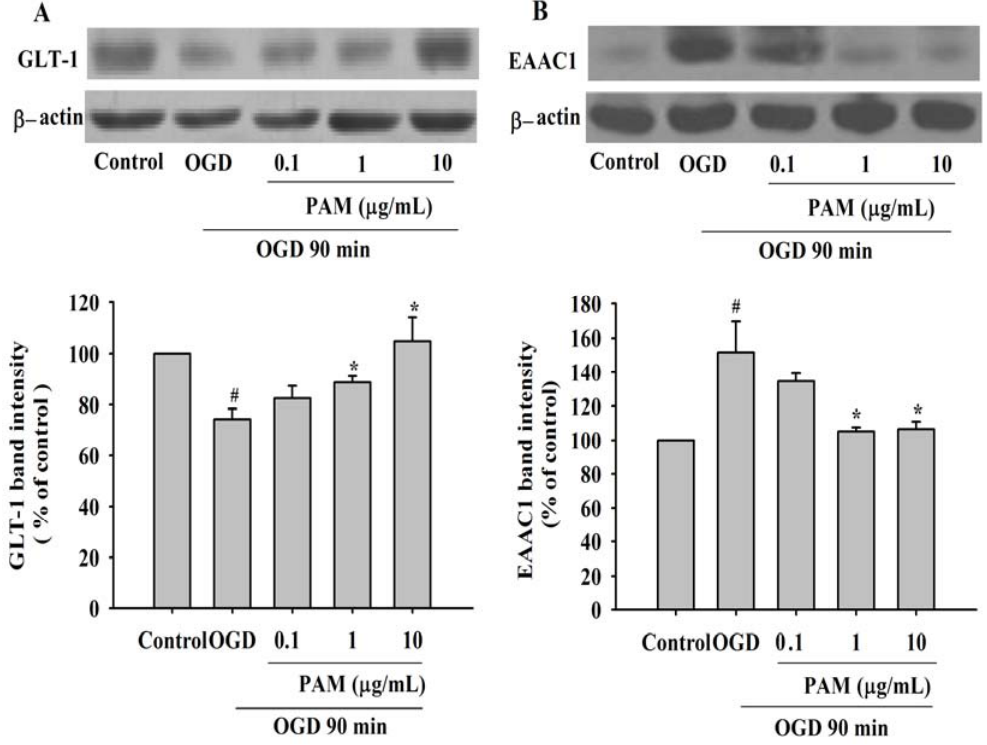
Figure 3. Effects of PAM on GLT-1 and EAAC1 protein expression in rat primary cortical cultures after OGD 90 min. ( A ) Representative Western blot images of GLT-1 and